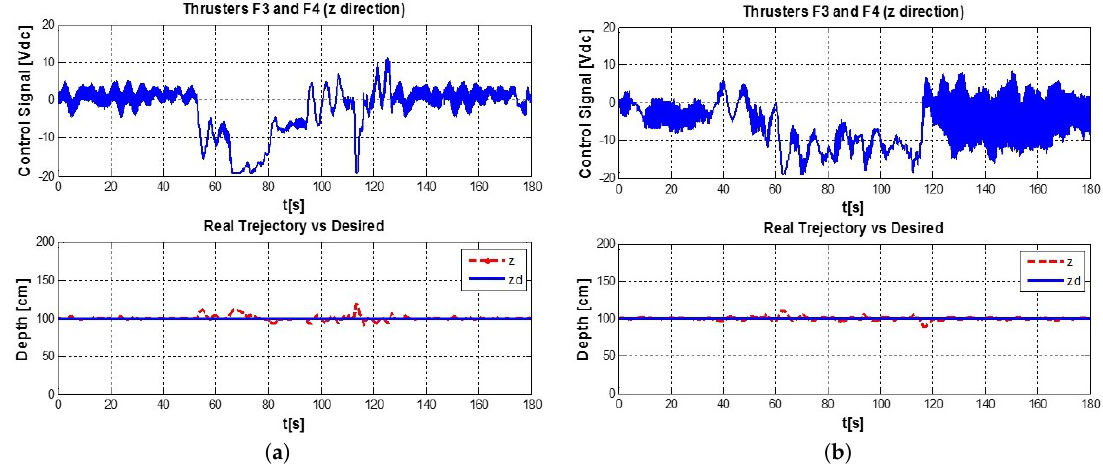
Figure 20. ( a ) Conventional PID Controller, ( b ) auto-tuned PID.